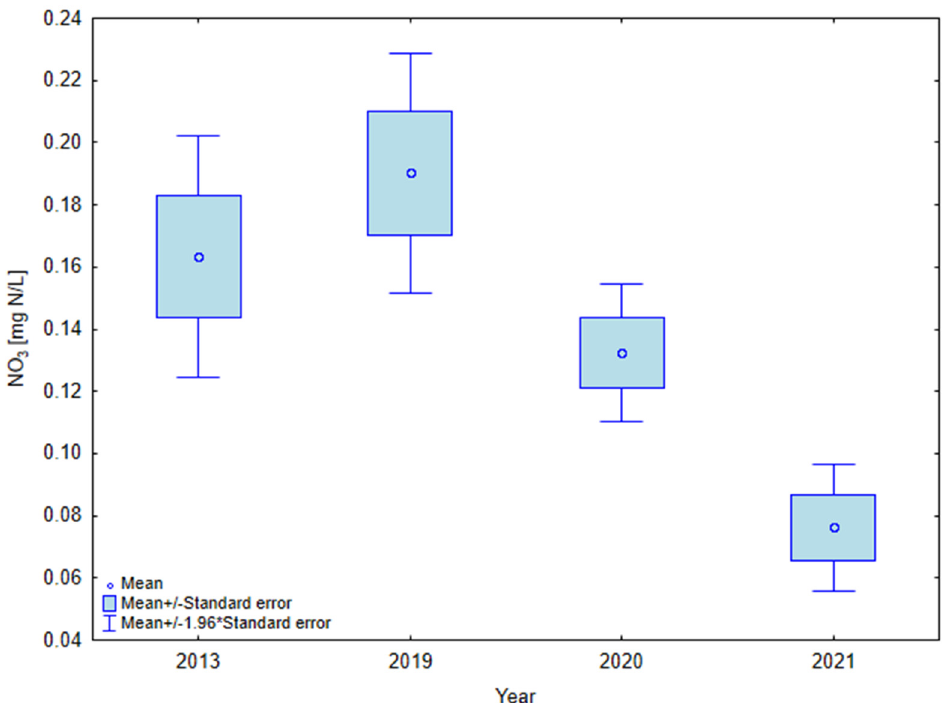
Figure 2. Average annual values of NO 3 content in the water of Mielenko Lake.